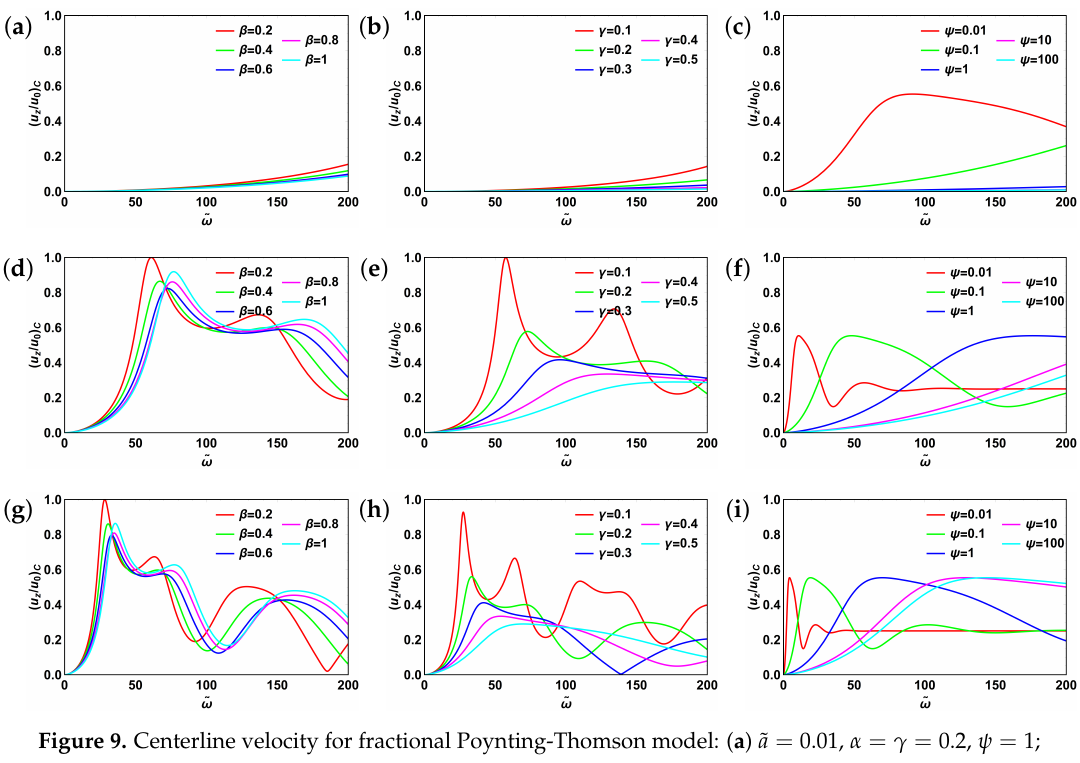
Figure 9. Centerline velocity for fractional Poynting-Thomson model: ( a ) ˜ a = 0.01, α = γ = 0.2, ψ = 1; ( b ) ˜ a = 0.01, α = β = 0.5, ψ = 1; ( c ) ˜ a = 0.01, α = β = γ = 0.5; ( d ) ˜ a = 0.05, α = γ = 0.2, ψ = 1; ( e ) ˜ a = 0.05, α = β = 0.5, ψ = 1; ( f ) ˜ a = 0.05, α = β = γ = 0.5; ( g ) ˜ a = 0.1, α = γ = 0.2, ψ = 1; ( h ) ˜ a = 0.1, α = β = 0.5, ψ = 1; ( i ) ˜ a = 0.1, α = β = γ = 0.5. Subscript “c” stands for